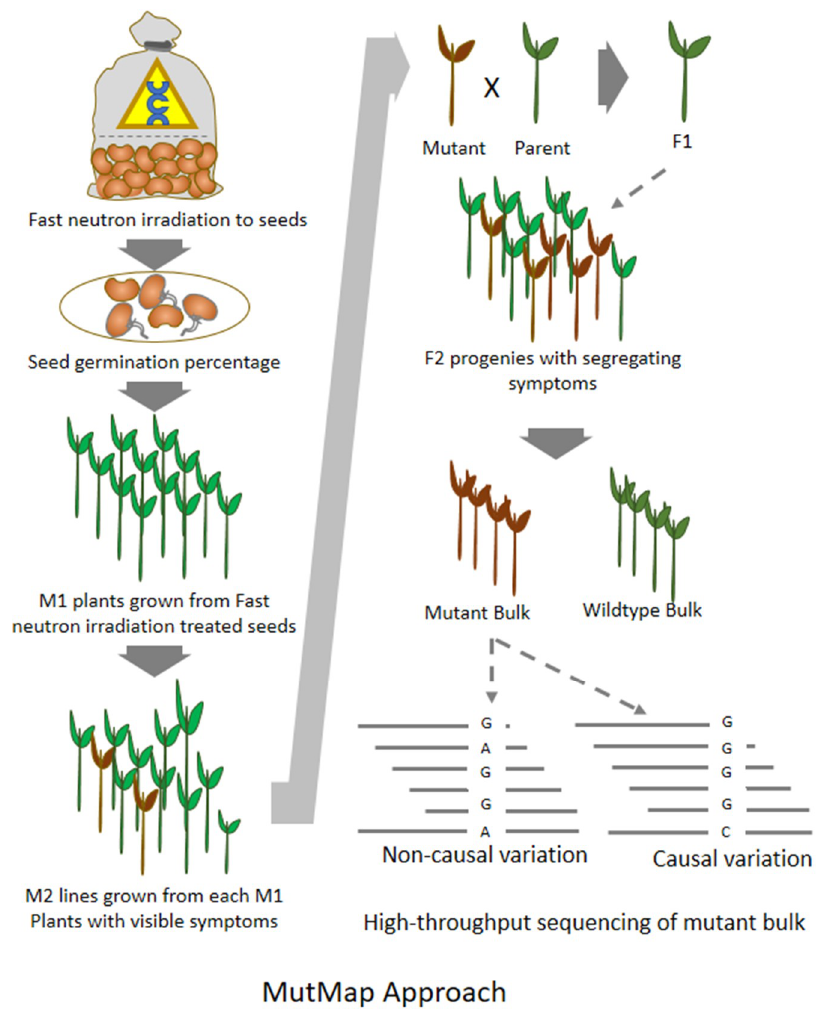
Figure 2. Generalized flowchart of mapping by mutation (MutMap) approach being used for the localization of casual mutation in small plant genomes like rice.